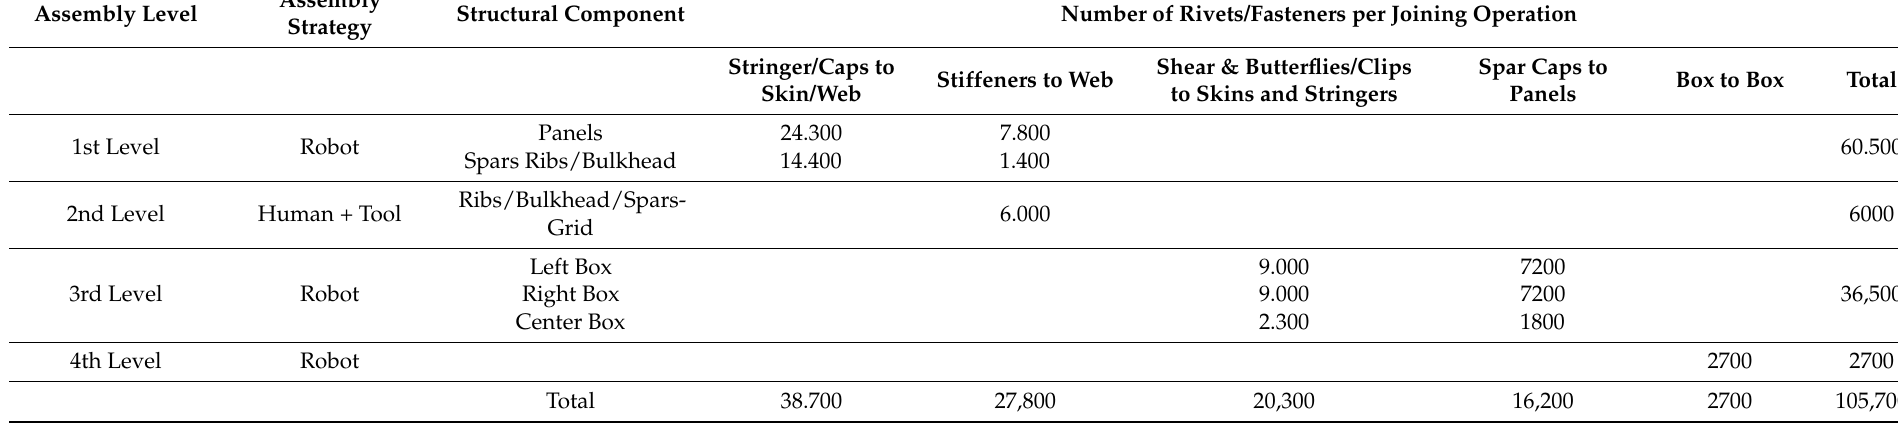
Table A1. Number of rivets/fasteners for a three-piece wing [19].